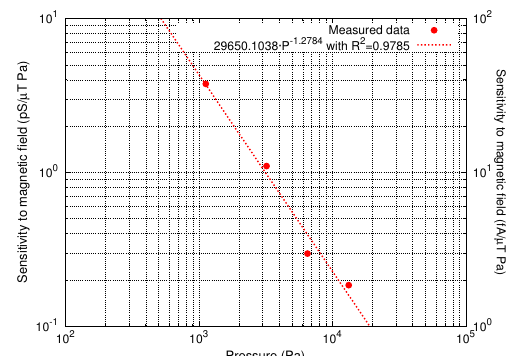
Figure 12. Device sensitivity to magnetic field, in pS ( µ T · Pa ) − 1 , as a function of pressure. Each data point is obtained from the slope of conductivity when applying a magnetic field sweep between ± 2 mT.